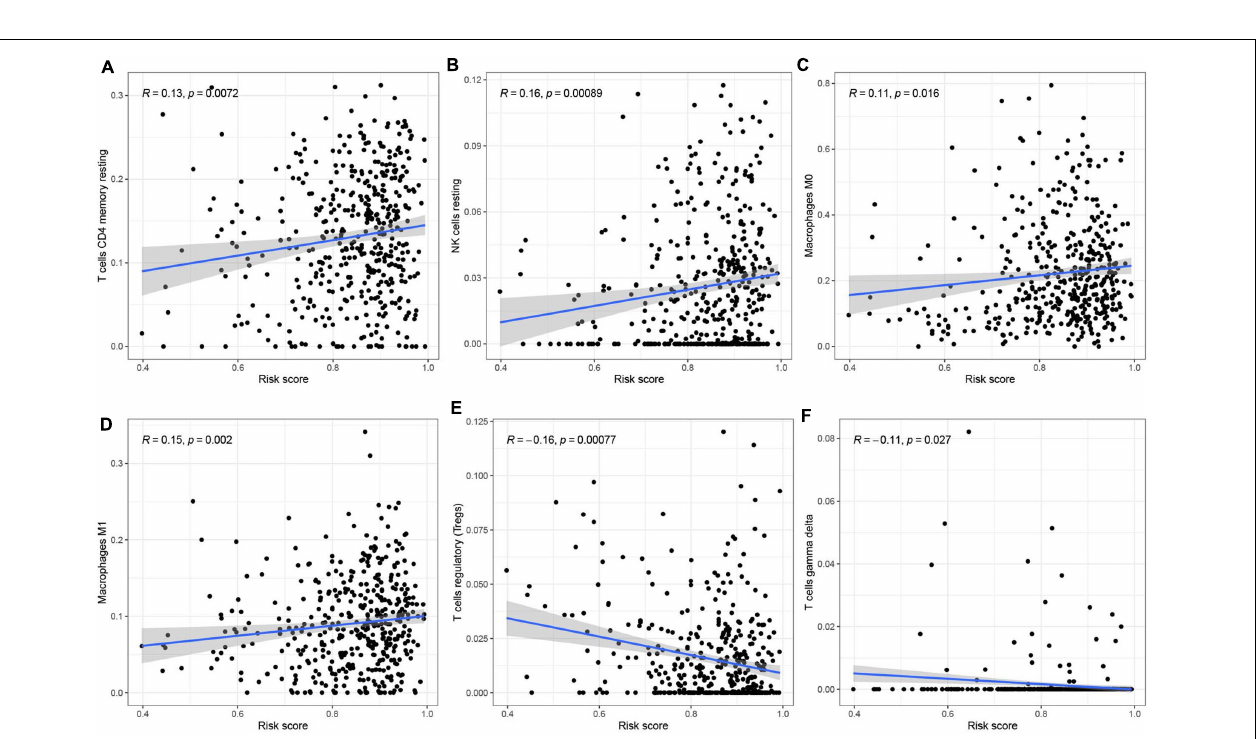
FIGURE 11 | Relationships between the risk score and infiltration abundances of six immune cell types. (A–F) T cells CD4 memory resting (A) , NK cells resting (B) , Macrophages MO (C) , Macrophages Ml (D) , T cells regulatory (Tregs) (E) , and T cells gamma delta (F) .